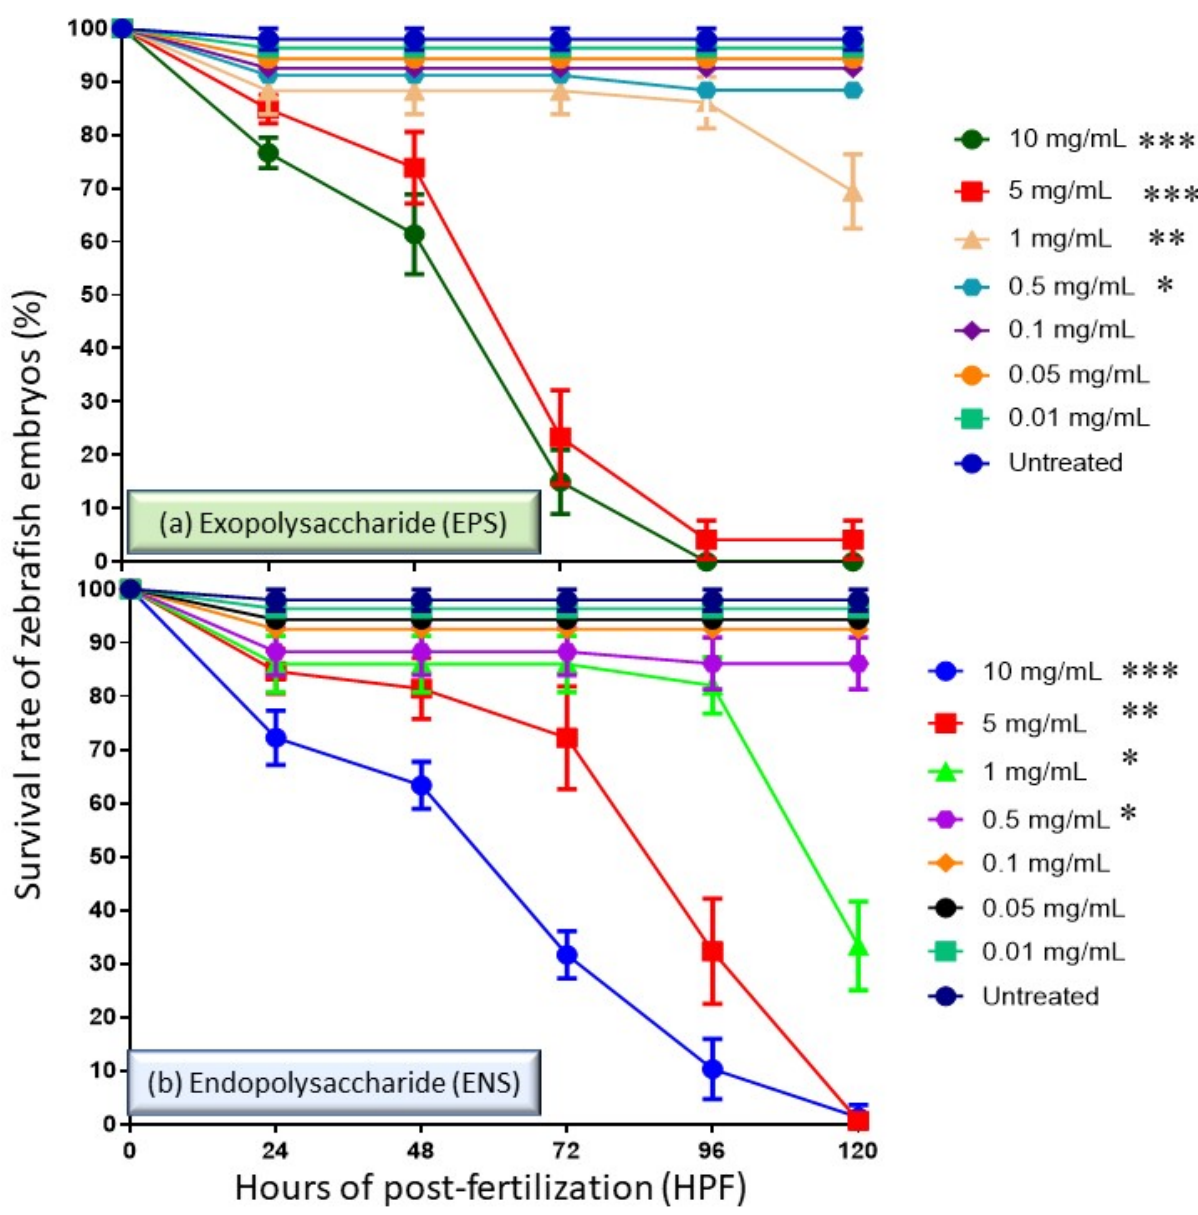
Figure 1. The performance of Ganoderma applanatum ( a ) EPS and ( b ) ENS extract at concentrations of 0.01–10 mg/mL on the survival rate of zebrafish embryos at 0–120 h. No embryos survived for both samples at concentration tested > 5.0 mg/mL after 96 h post fertilization (HPF). Symbols: * p ˂ 0.05, ** p < 0.01 and *** p < 0.001.